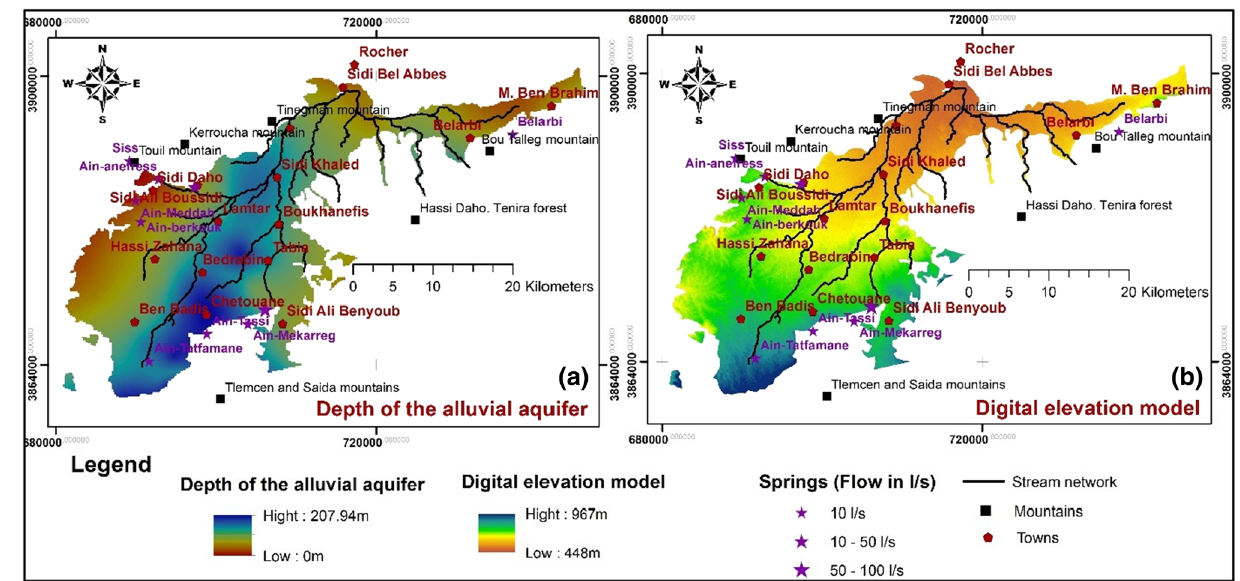
Fig. 5 Digital elevation model and aquifer thickness